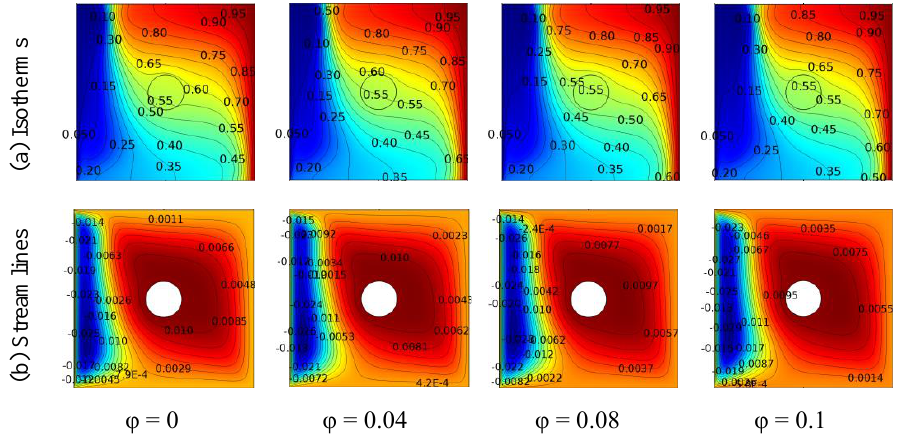
Fig. 5. isotherms (a) and Streamlines(b) for different values of φ,with Ha = 25, Ri